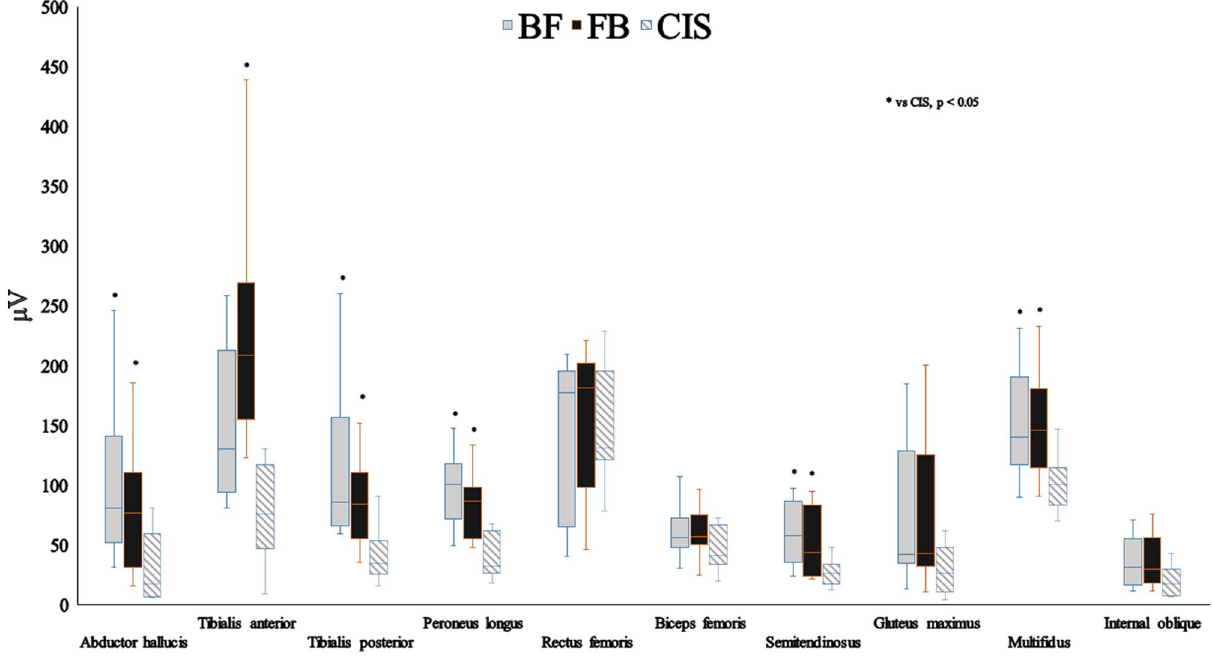
Figure 3. The median and interquartile range of muscle activity during each exercise task. BF back-to-front, FB front-to-back, CIS conventional isometric towel curl exercises in participants with pronated feet 30 . Recreational runners who performed a foot exercise program had a 2.42-fold lower risk of running-related injuries compared to the control group 26 . Further, 6 weeks of short-foot exercise intervention reduced navicular drop, foot pronation, foot pain, disability, and increment in plantar force of the medial midfoot in pes planus 32 . These previous studies indicate the importance of improving the function of the foot and ankle muscles. The results of this study showed that the activity of foot and ankle muscles was increased in HSS that required postural control in the weight-bearing position. In unstable conditions, the activities of flexor digitorum longus, peroneus brevis and TA were increased 33 . The activities of the abductor pollicis brevis, flexor digitorum brevis, and plantaris quadratus muscles were analyzed in different positions, and these muscles were activated more during weight-bearing 34 . The activity of the PL and abductor pollicis longus muscles during the short-foot exercise was significantly higher in the standing position than in the sitting position 31,35 . Therefore, the present